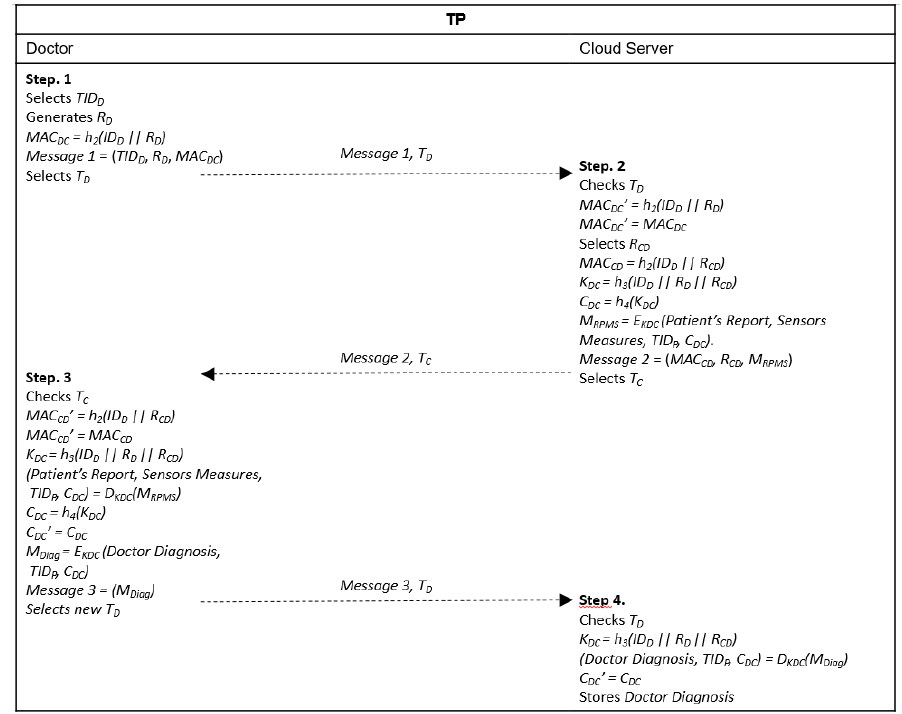
Figure 5. Message exchange in treatment phase (TP).